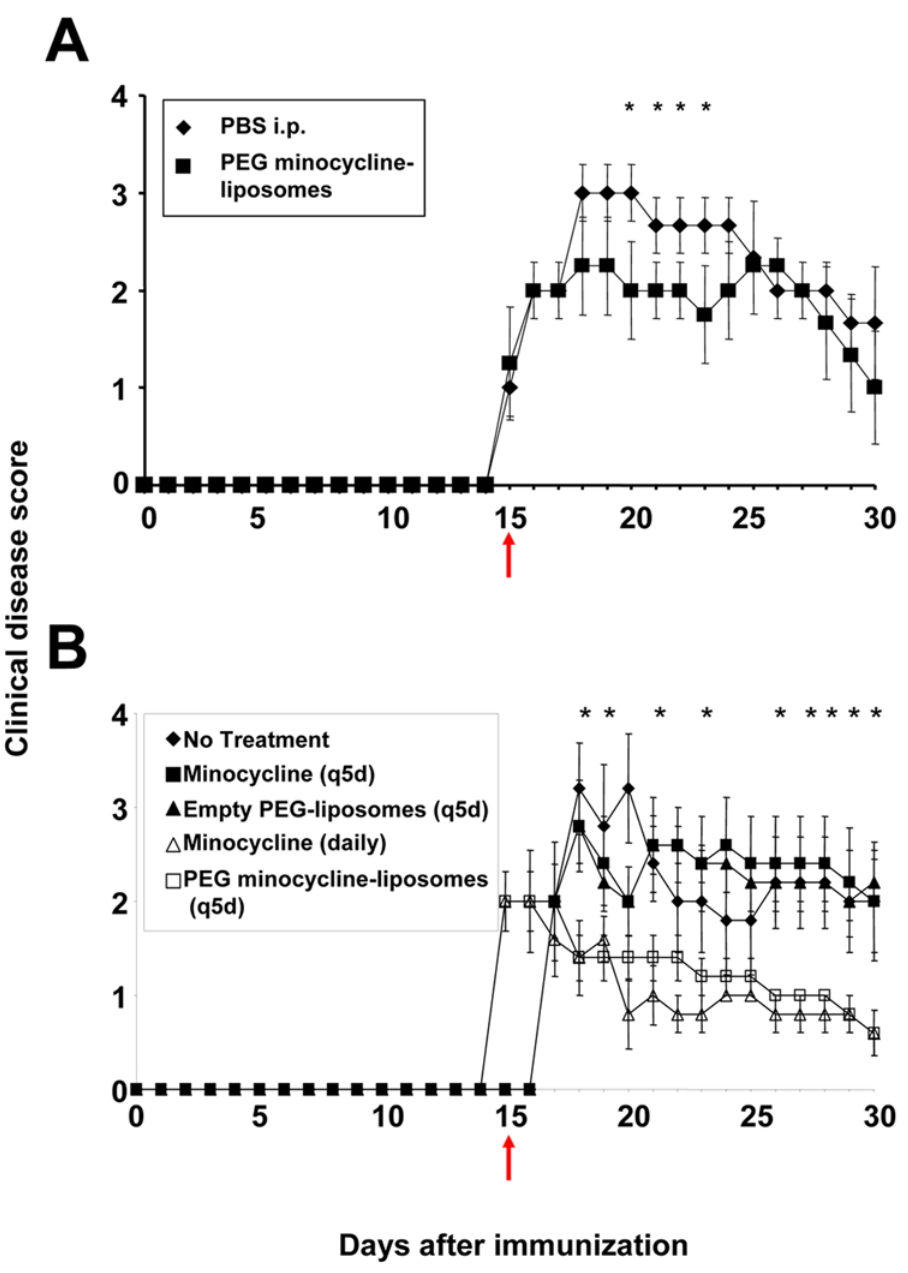
Figure 2. Effects of long-circulating polyethylene glycol (PEG) minocycline-liposomes on the clinical course of experimental autoimmune encephalomyelitis (EAE). A single intravenous (i.v.) injection of PEG minocycline-liposomes given after disease onset at day 15 post-immunization resulted in significant amelioration of clinical disease for eight days compared to a single injection of PBS when given shortly after onset of clinical disease (A). This effect was not sustained (A). In subsequent experiments, PEG-liposomes were administered every five days. Treatment with i.v. PEG minocycline-liposomes initiated after disease onset at day 15 post-immunization and administered every five days was as effective in ameliorating clinical EAE as treatment with daily intraperitoneal (i.p.) injections of minocycline (B). In contrast, i.v. injections of empty PEG- liposome every five days, or minocycline i.p. injections every five days had no detectable effect on the clinical course of EAE (B). The time of treatment initiation is indicated by a red